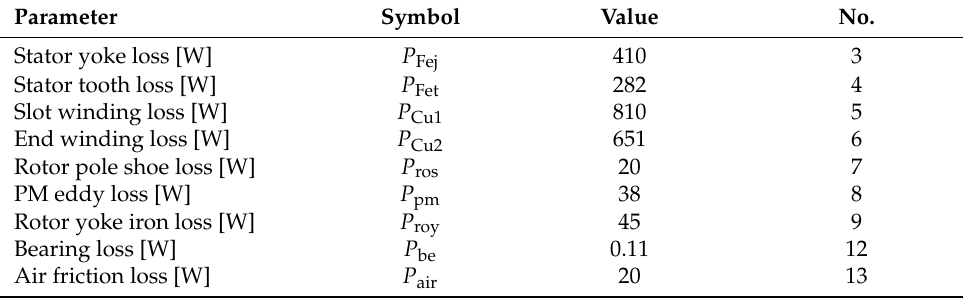
Table 6. Loss value of IPMSM